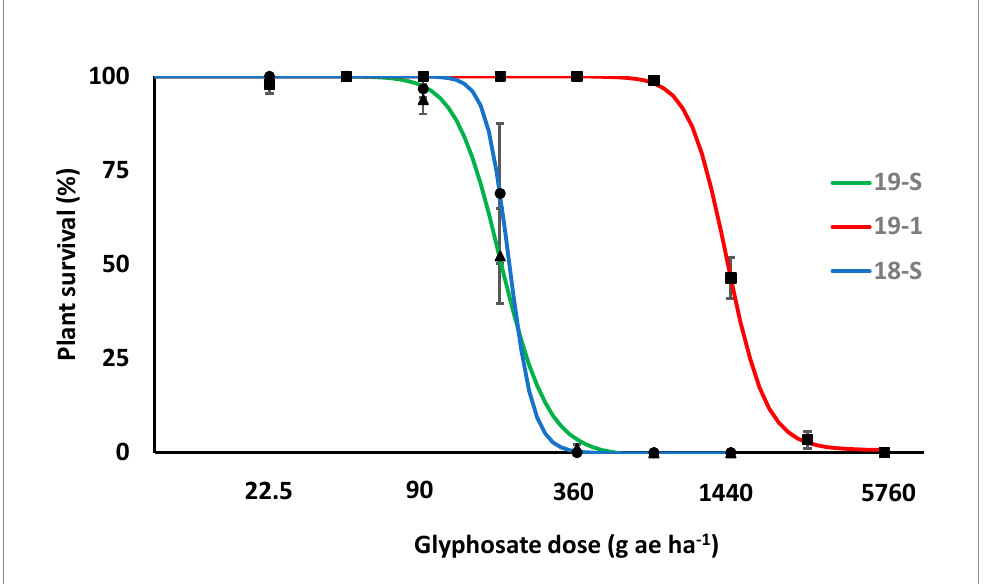
Figure 2. Plant survival response (%) to increasing glyphosate dose of the putative GR biotype (19-1, red line) and the two susceptible reference biotypes (18-S and 19-S, blue and green lines, respectively). Values are the mean of the two experiments, i.e., six replicates. Bars represent standard errors.